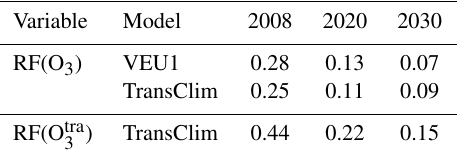
Table 6. Radiative forcing of ozone change (O 3 ) and contribution change (O tra ) in mWm − 2 due to German road traffic emissions for 3 the years 2008, 2020, 2030. The results for the VEU1 simulations with EMAC (Hendricks et al., 2018) and TransClim are